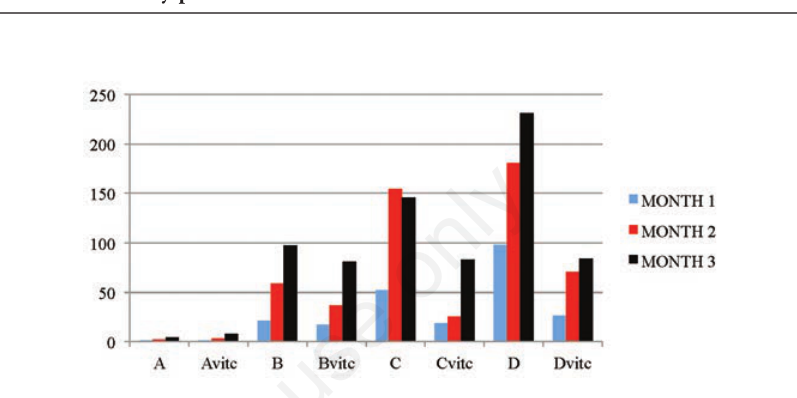
Figure 4. The mean serum creatinine ( μ mol/L) values of the different subgroups during the three months study period.